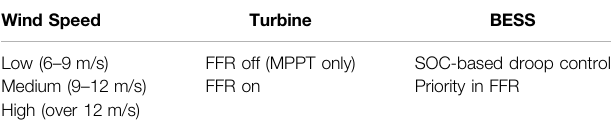
TABLE 2 | Coordinated frequency support